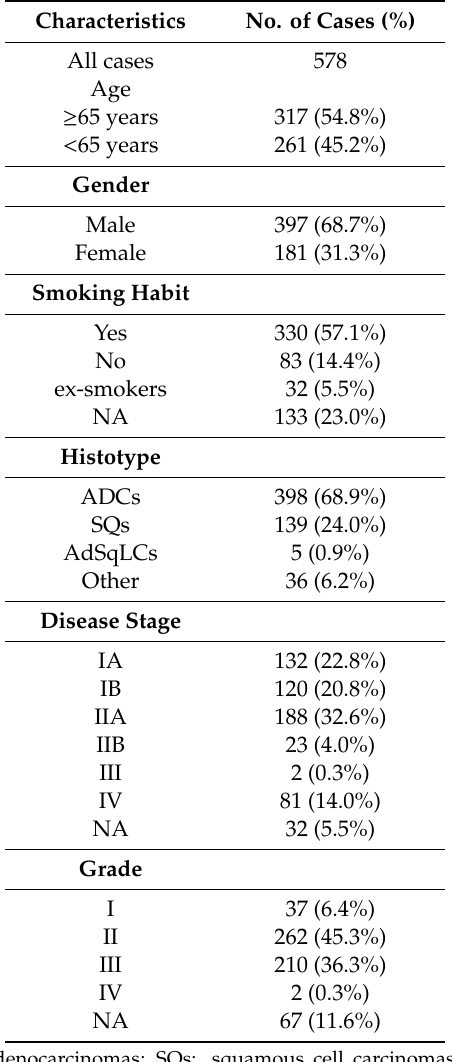
Table 1. Clinical and pathological features of